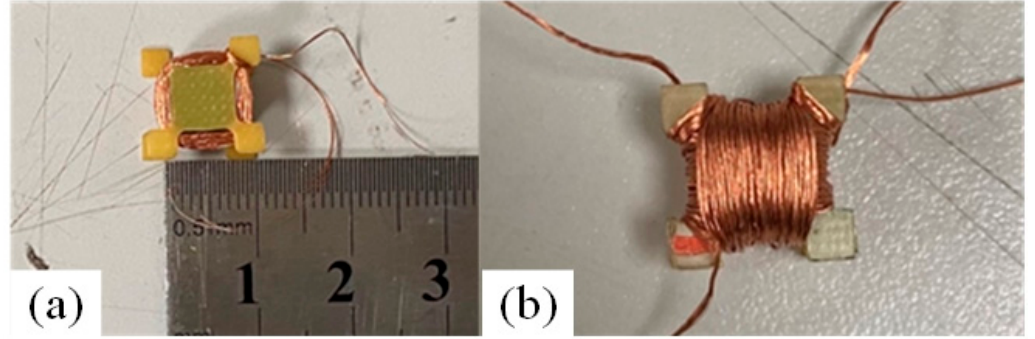
Figure 7. The prototype of receiving coil. ( a ) Finished product of first-dimensional receiving coil. ( b ) Finished product of three-dimensional receiving coil.